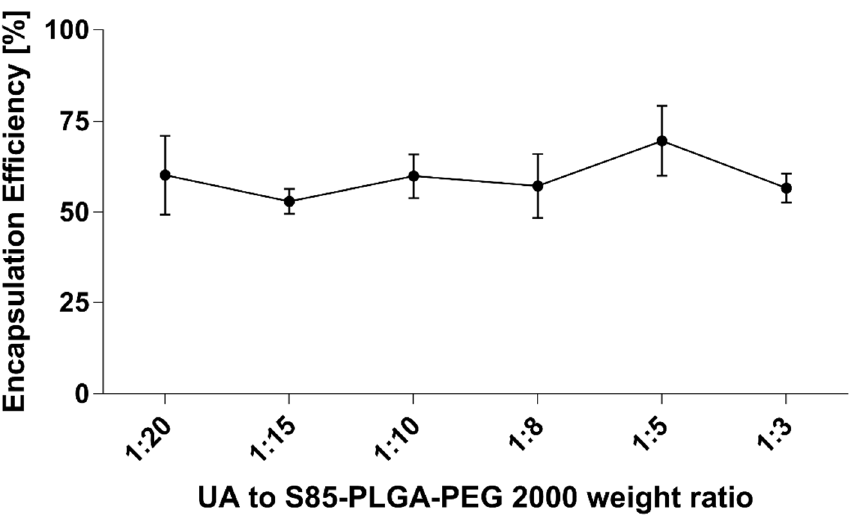
Figure 8. Ursolic acid encapsulation efficiency with different UA-to-S85-PLGA-PEG 2000 weight ratios.